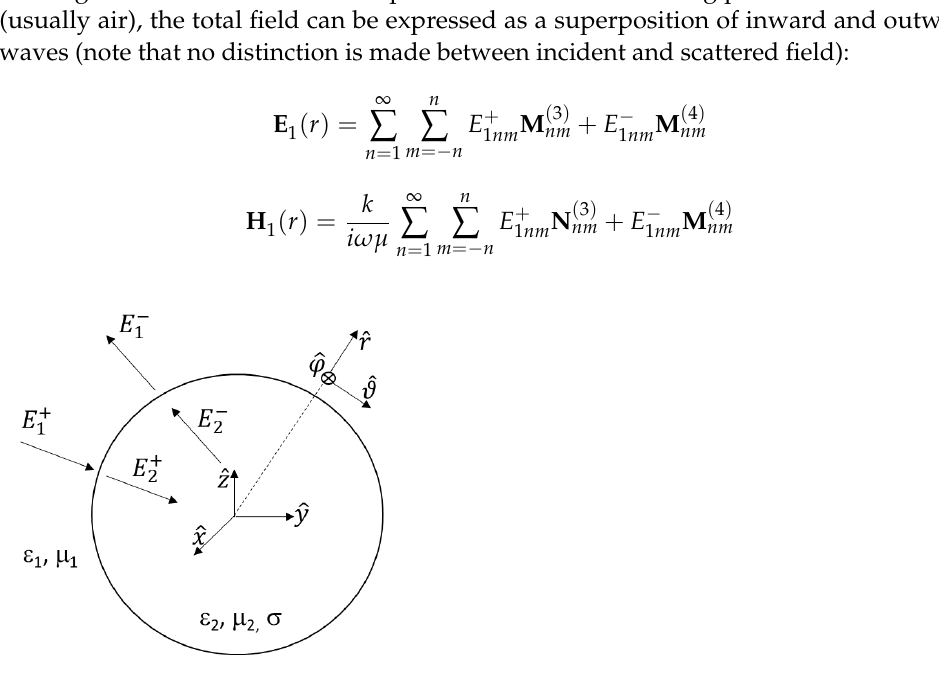
Figure 1. Geometrical representation of the scattering problem. The field in each medium is expressed as the combination of inward and outward spherical waves.